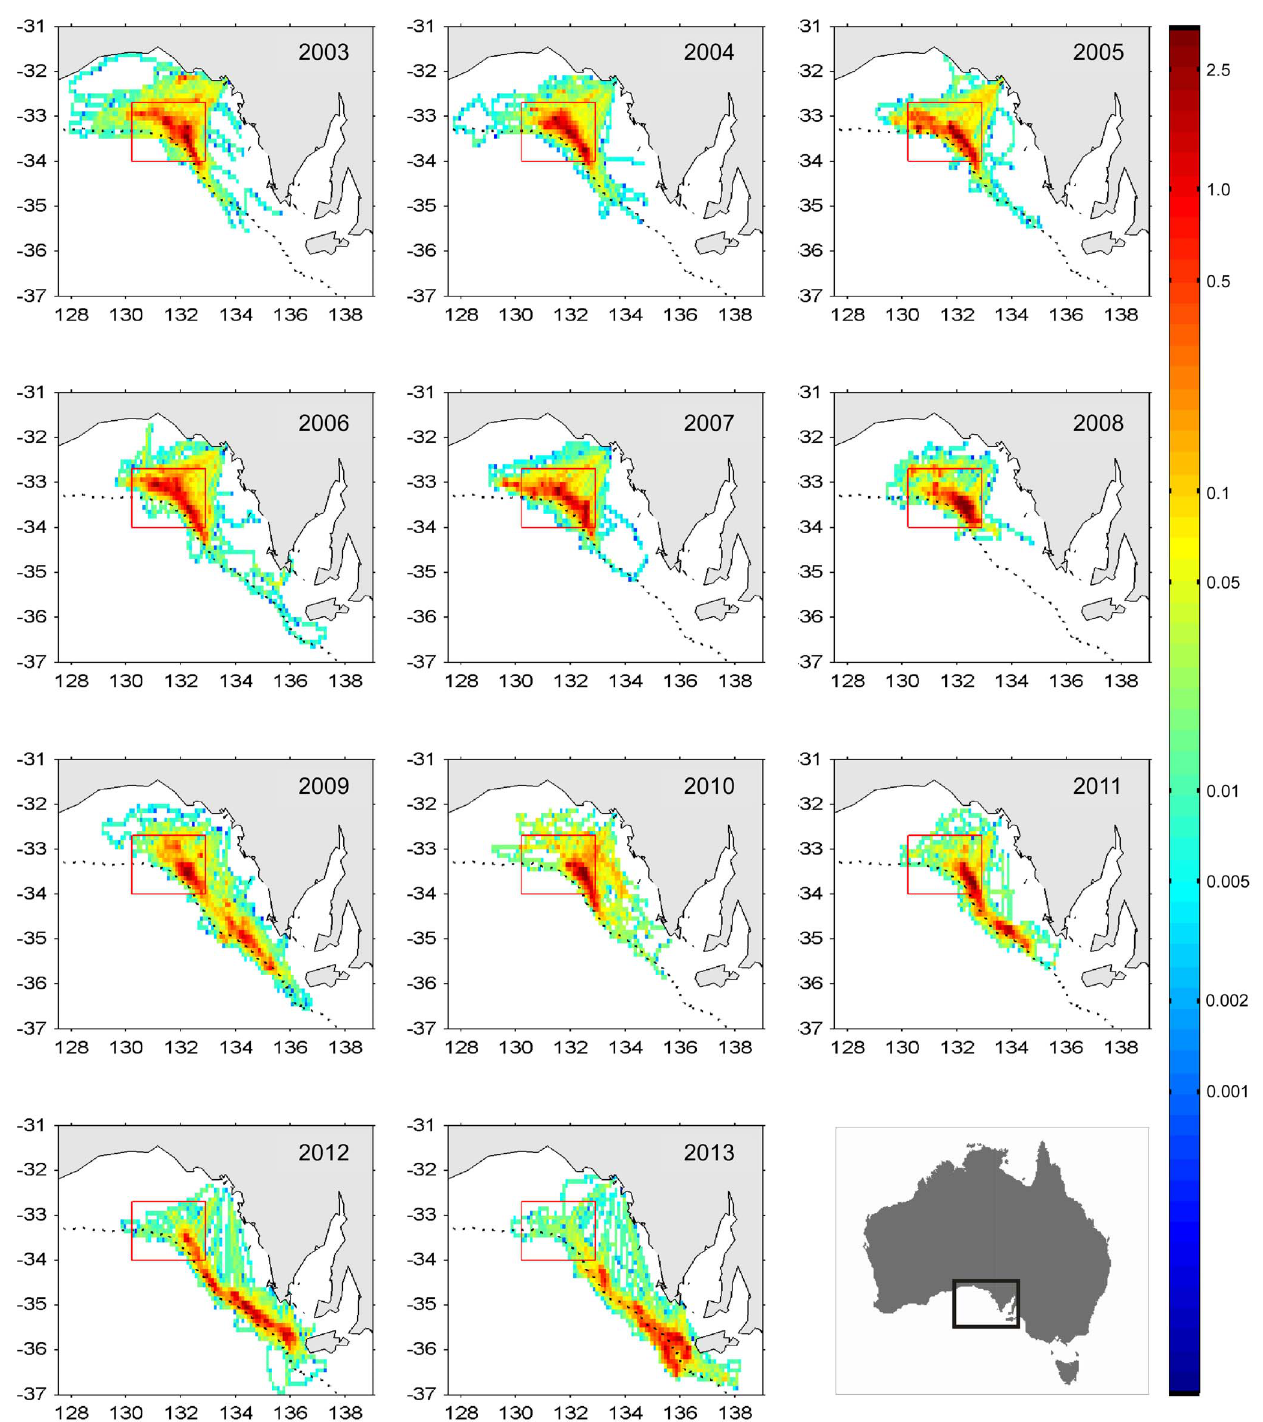
Fig. 1. Location and intensity of search effort in the Great Australian Bight by fishing season. Search effort is measured in nautical miles flown per 0.1 ˚ square. The core fishing area is shown by a red square for reference, and the dotted line indicates the 200 m depth contour (shelf break). Search effort for flights where GPS tracks were not available is not